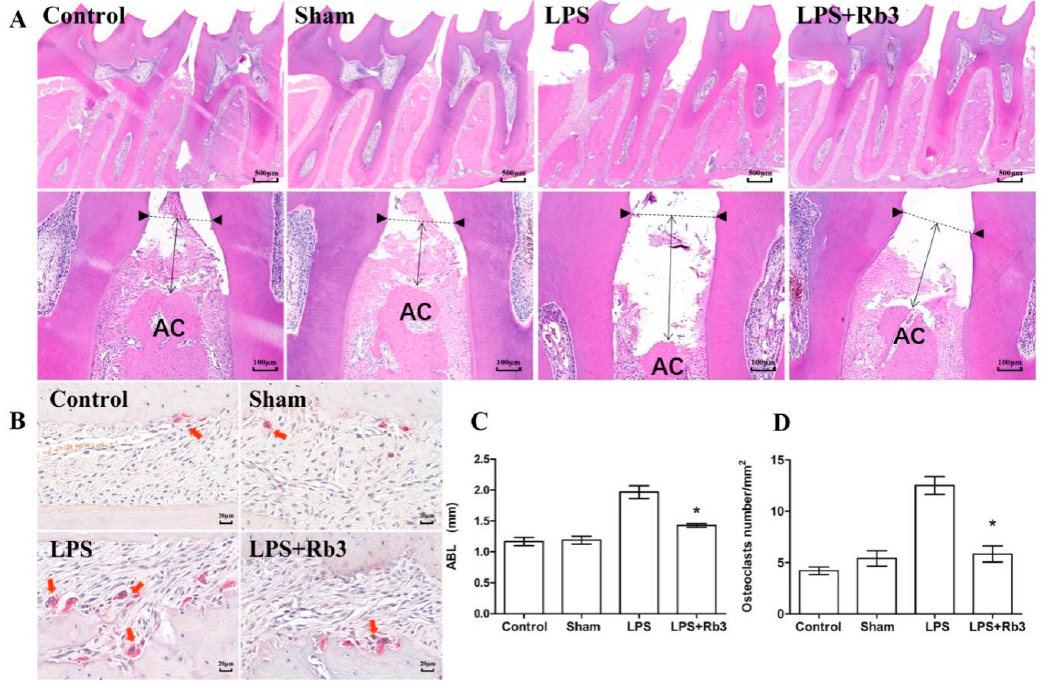
Figure 7. Rb3 attenuated P. gingivalis LPS-induced osteoclast di ff erentiation and bone resorption in rats. ( A ) ABL was compared from H&E staining slides. Black triangles represent CEJ, and distance from CEJ to AC was measured between first-second molars of rats. ( B ) Tartrate-resistant acid phosphatase (TRAP) staining for maxilla slides of rats. Red staining cells (arrows) are osteoclasts and their immediate precursors. ( C ) ABL were calculated and presented in bar graph. ( D ) Osteoclasts were enumerated and presented in bar graph. Data were presented as means ± SE (n = 4 rats / group). * p < 0.05 versus LPS group. CEJ, cemento-enamel junction; ABL, alveolar bone loss; AC, alveolar bone; SE, standard error.